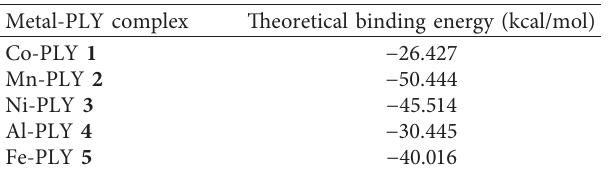
Figure 7: Emission spectra of EB bound to DNA in the presence of the complexes (a) Co-PLY 1 , (b) Mn-PLY 2 , (c) Ni-PLY 3, (d) Al-PLY 4 , and (e) Fe-PLY 5 . The arrow shows the intensity changes upon increasing concentrations of the complex (0, 0.23, 0.46, 0.70, 0.93, and 1.16mM, respectively). Inset: (plots of I 0 /I versus (metal complex)/(DNA)). Table 7: Binding free energy values of metal-PLY complexes (1 – 5) with SS-DNA as calculated from molecular